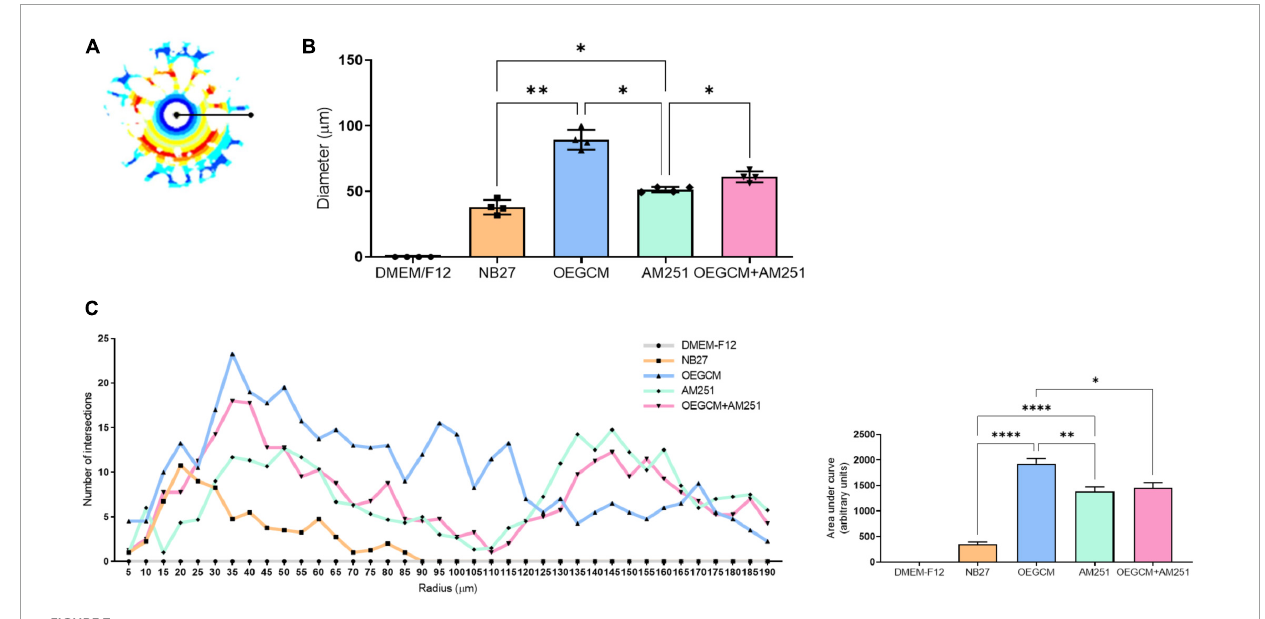
FIGURE7 Sholl analysis from MBP immunocytochemistry shows that CB1 blockade decreases process branching complexity of oligodendrocytes stimulated by OEGCM. In panel (A) , the Sholl circles from one MBP positive oligodendrocyte from OEGCM condition. In panel (B) , the diameter from MBP positive oligodendrocytes in the different conditions. Data is presented as mean ± SD, statistical analysis of AUC was performed using One-way ANOVA and Sídák’s as post hoc test. N = 4 for all experimental conditions, p = 0.0024 for NB27 vs. OEGCM, p = 0.0427 for NB27 vs. AM251, p = 0.0568 for OEGCM vs. OEGCM + AM251, p = 0.0472 for AM251 vs. OEGCM + AM251, p = 0.0101 for OEGCM vs. AM251. In panel (C) , the area under the curve calculates the number of intersections in every 0.5 µ m radium in each Sholl circle. Data is presented as mean ± SD, statistical analysis of AUC was performed using One-way ANOVA and Sídák’s as post hoc test. N = 4 for all experimental conditions, p < 0.0001 for NB27 vs. OEGCM, p < 0.0001 for NB27 vs. AM251, p = 0.0117 for OEGCM vs. OEGCM + AM251, p = 0.9831 for AM251 vs. OEGCM + AM251, p = 0.0040